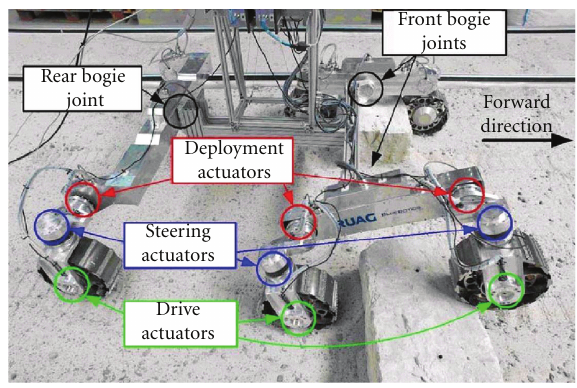
Figure 1: ExoMars rover in DLR’s PEL (Planetary Exploration Laboratory) [6].